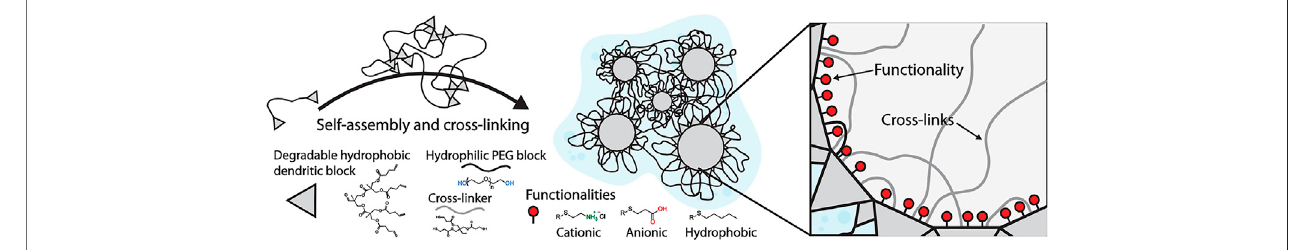
FIGURE3| Preparation illustration ofnanogelsand drugrelease behaviors. (A) Anillustration ofself-assemblednanogels; (B) The nanogelparticle sizedistribution with ratio 1:100; (C) Release characteristics of Ex4 and Ex4-C16 from nanogels (Lee et al., 2012). Copyright (2012) Elsevier.